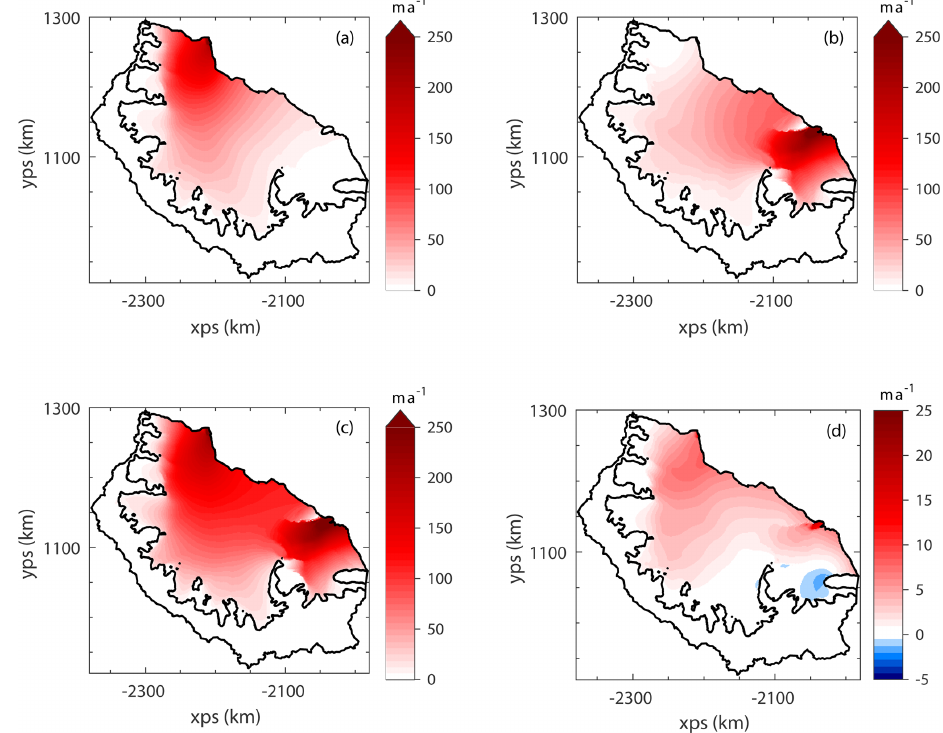
Figure 5. Ungrounding experiments: the change in modelled ice speed after ungrounding at the Bawden Ice Rise (a) , the Gipps Ice Rise (b) and at both ice rises simultaneously (c) . The difference between the combined ungrounding and the sum of the two individual un- grounding experiments is shown in (d) . Note the different scale of the colour bar in (d) . In panels (a) – (c) there is a small speed decrease (typically < 10ma − 1 ) at a few computational nodes that is not visible when plotted, and therefore the colour scale has been truncated at zero for